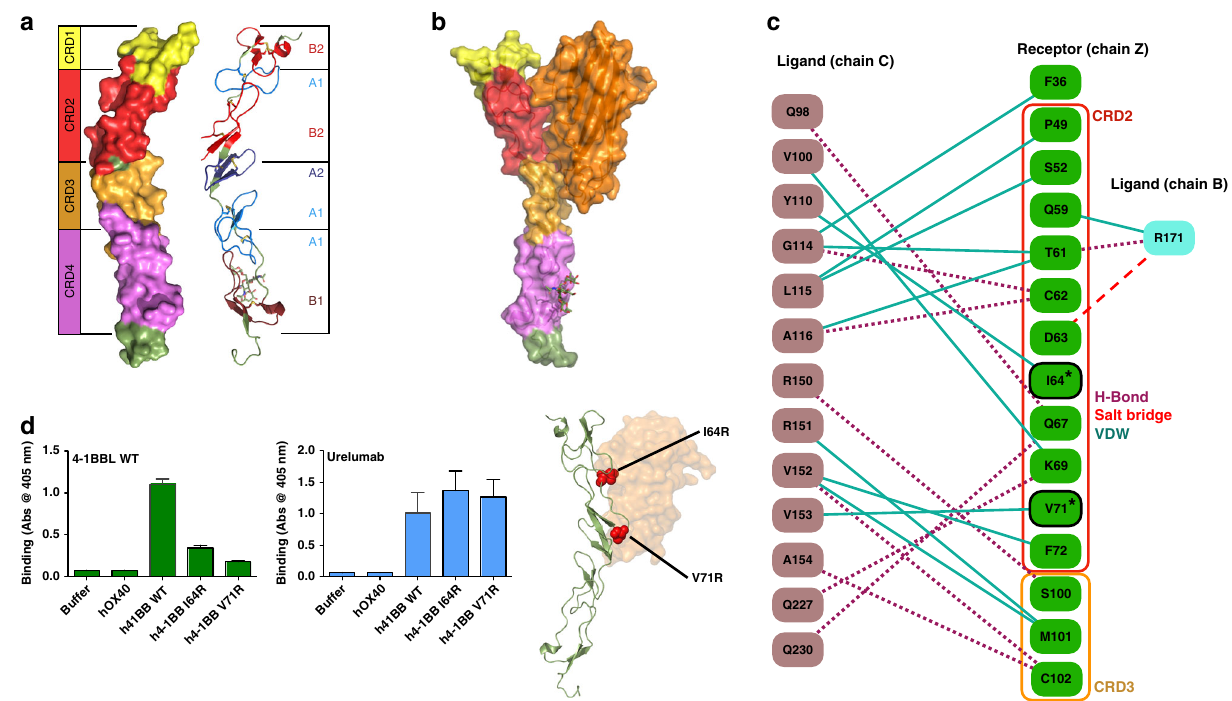
Fig. 2 4-1BB CRD organization and interaction between receptor and ligand. a Breakdown of the CRD organization in the 4-1BB receptor ranging from CRD1 at the N-terminus to CRD4 at the C-terminus, highlighted on the left. Structural A and B motifs making up each individual CRD are highlighted on the right. b Side view of interaction between a single ligand protomer and receptor. 4-1BB ligand binds to CRD2 and CRD3 of the receptor. c Schematic diagram detailing the signi fi cant interactions between receptor chain Z (green) and ligand chains B (teal) and C (dark pink). Hydrogen bonds, salt-bridges, and van der Waals interactions are indicated in purple dashed lines, red dashed lines, and dark teal lines, respectively. Receptor residues mutated in D are outlined in black and marked with an asterisk. d Receptor mutants I64R and V71R were chosen to disrupt interaction with the ligand. Biotinylated wild type h4-1BB ligand was incubated with captured wild type or mutant h4-1BB receptor before washing and detection with streptavidin-HRP. Wild type ligand showed reduced binding to both I64R and V71R mutants relative to wild type receptor. Urelumab bound wild type and I64R and V71R mutant 4-1BB at similar levels indicating that mutant receptors were properly folded. Structure depicts position of receptor mutants. Data shown as mean with s.d. ( N = 3). Receptor is shown in forest green cartoon with mutation sites highlighted in red spheres. Ligand (orange) is shown as a transparent